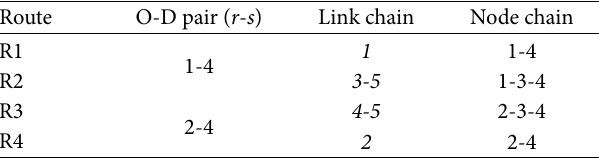
Figure 1: A small size triangle network. Table 3: Route-link incidence.